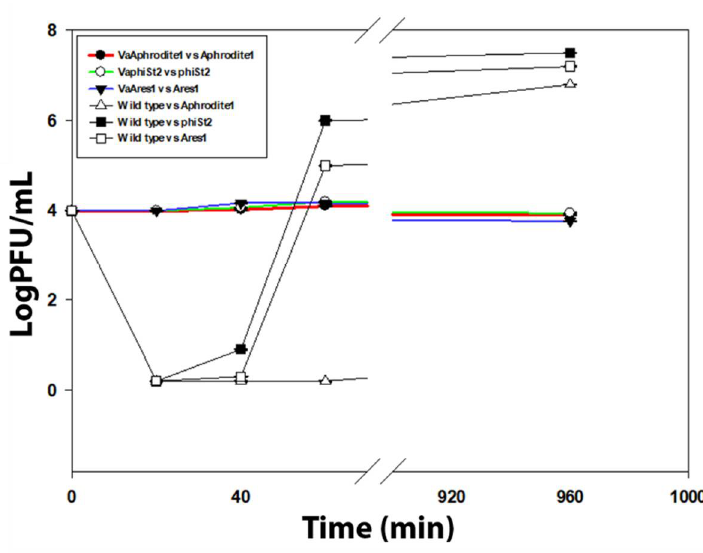
Figure 2. Adsorption assay for bacteriophages Aphrodite1, phiSt2, and Ares1 against their corre- sponding resistant strains. Initial titer was 10 4 , and cultures upon infection were in their exponential phase ( ± SE; n = 3).